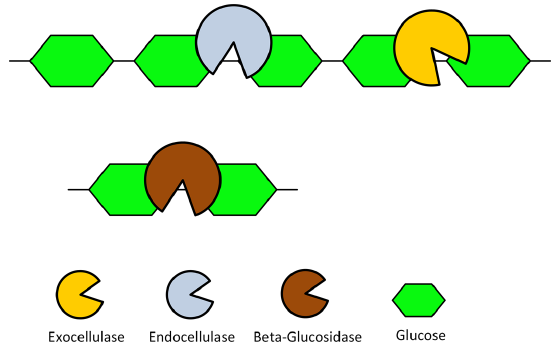
Figure 4. Basic structural component of cellulose and the cellulases responsible for its degradation.